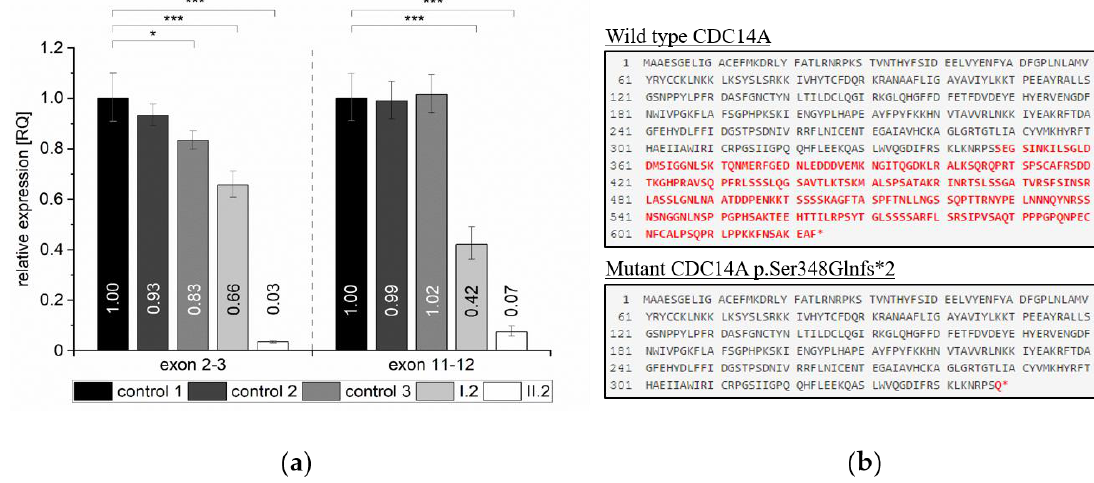
Figure 3. Quantification of the RT-qPCR relative expression values for the CDC14A c.1041dup variant in homozygous, heterozygous and wild type control individuals. ( a ) Relative expression levels are shown for exon 2–3 (F (4, 10) = 150.69) and exon 11–12 (F (4, 10) = 112.84) for the normalized reference samples (wt controls 1, 2 and 3), and both tested individuals in family 2 (I.2, heterozygous for c.1041dup and II.2, homozygous for c.1041dup). N = 3 for each group. Values are represented as means and error bars extend to the respective minimal and maximal values. To improve readability, significant di ff erences are only indicated for pairwise comparisons to the normalized reference sample (wt control 1). See Supplementary Table S2 for extended information. * p < 0.05 and *** p < 0.001. ( b ) E ff ect of the c.1041dup variant on the protein, comparing wild type (top) and the truncated (bottom) protein resulting from the aberrantly spliced product (visualized with Mutalyzer). The amino acid residues marked in red are those that are altered due to the